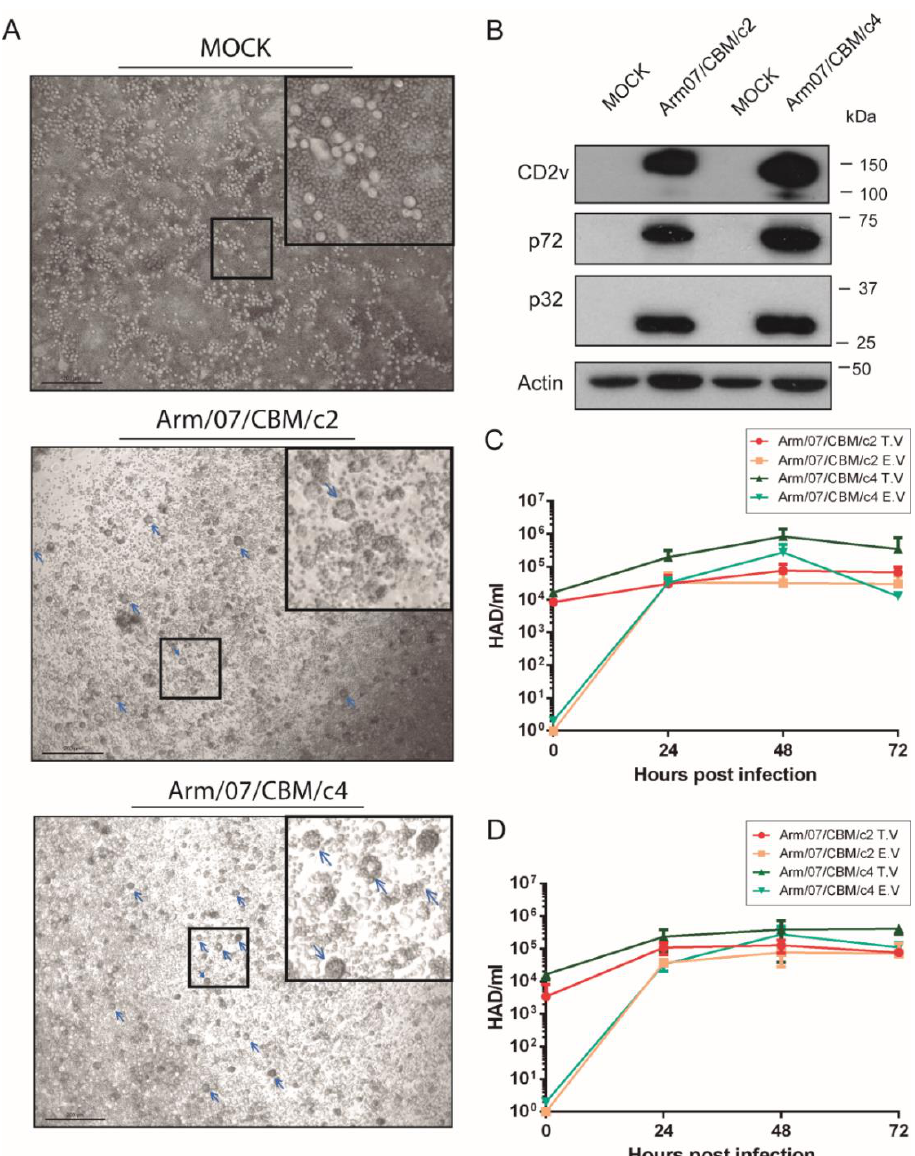
Figure 7. Arm/07/CBM/c2 and Arm/07/CBM/c4 clones express functional CD2v and have a similar capacity for growth in PAMs. PAMs were mock-infected or infected with either Arm/07/CBM/c2 or Arm/07/CBM/c4 (MOI = 0.5) for 16 h. Then, ( A) porcine erythrocytes were added and after 24 h, rosettes (blue arrows) were detected on a light microscope. ( B ) cells were lysed in RIPA buffer and lysates were separated by 7–20% SDS-PAGE, followed by immunoblotting with anti-CD2v, anti-p72, anti-p32 ASFV proteins or anti-actin. PAMs ( C ) or COS cells ( D ) were infected with either Arm/07/CBM/c2 or Arm/07/CBM/c4 for 24, 48 or 72 h and the total (TV) and extracellular (EV) virus was then assayed for HAD activity. Scale bar in A represents 200 µm.